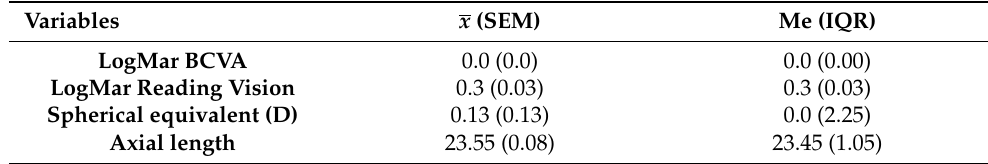
Table 1. Ocular characteristics of COVID-19